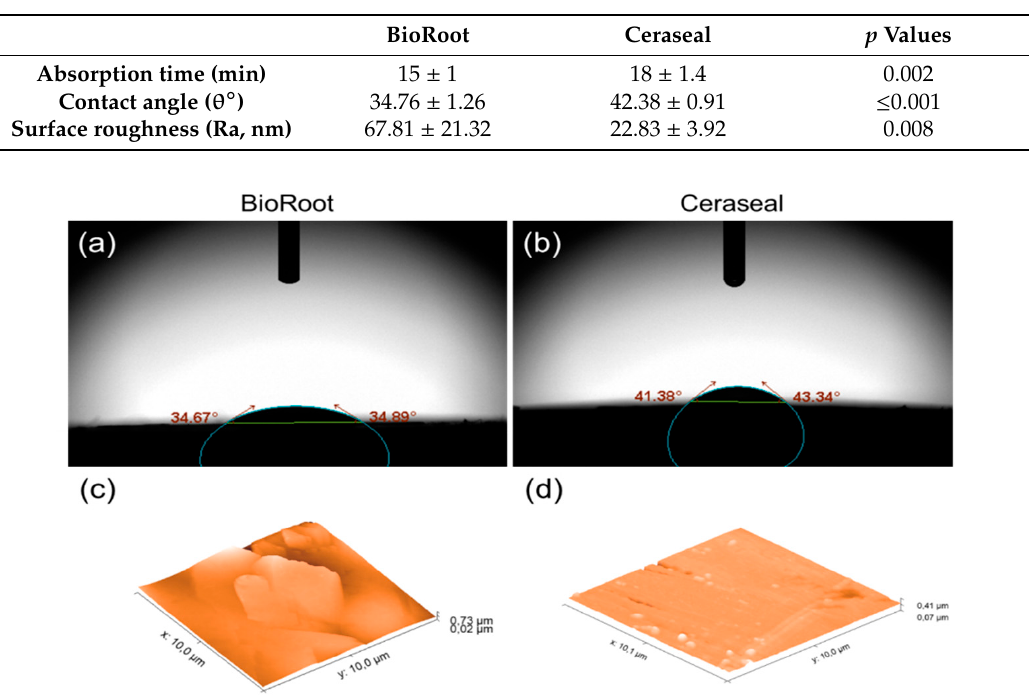
Table 5. Evolution of the time required for the two sealers to engulf a 5 µ L water droplet, the profile of the water drop after 10 s of deposition on the sealer surface, and the surface roughness mean values and standard deviations.